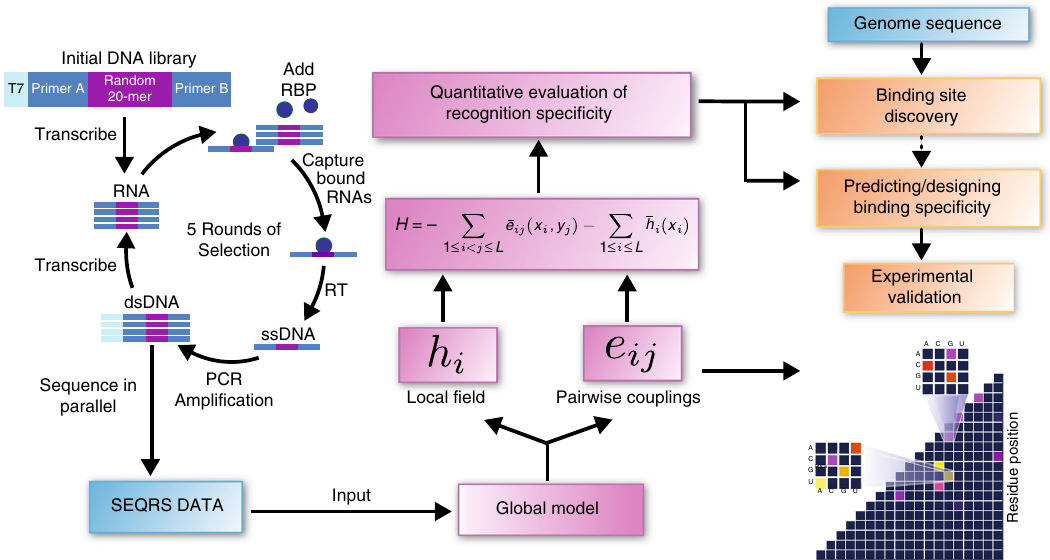
Fig. 1 DCA-scapes provide global models of RNA recognition. RNA-binding proteins are incubated with libraries of in vitro transcribed RNA containing a 20 base random region (scheme adapted from ref. 46 ). RNA – protein complexes are isolated through washing and reverse transcribed to cDNA. Transcription adapters are attached to the library using PCR and the selection process is repeated for fi ve rounds. After selection, the pool is subjected to high- throughput sequencing. The 20-mer region is used as an input for the creation of a global model. The model considers both the local nucleotide propensities and pairwise couplings to calculate a Hamiltonian score. These scores can be used to detect binding sites and predict the outcome of speci fi c mutations. Pairwise interactions are visualized on a landscape and provide hints of molecular interactions relevant for